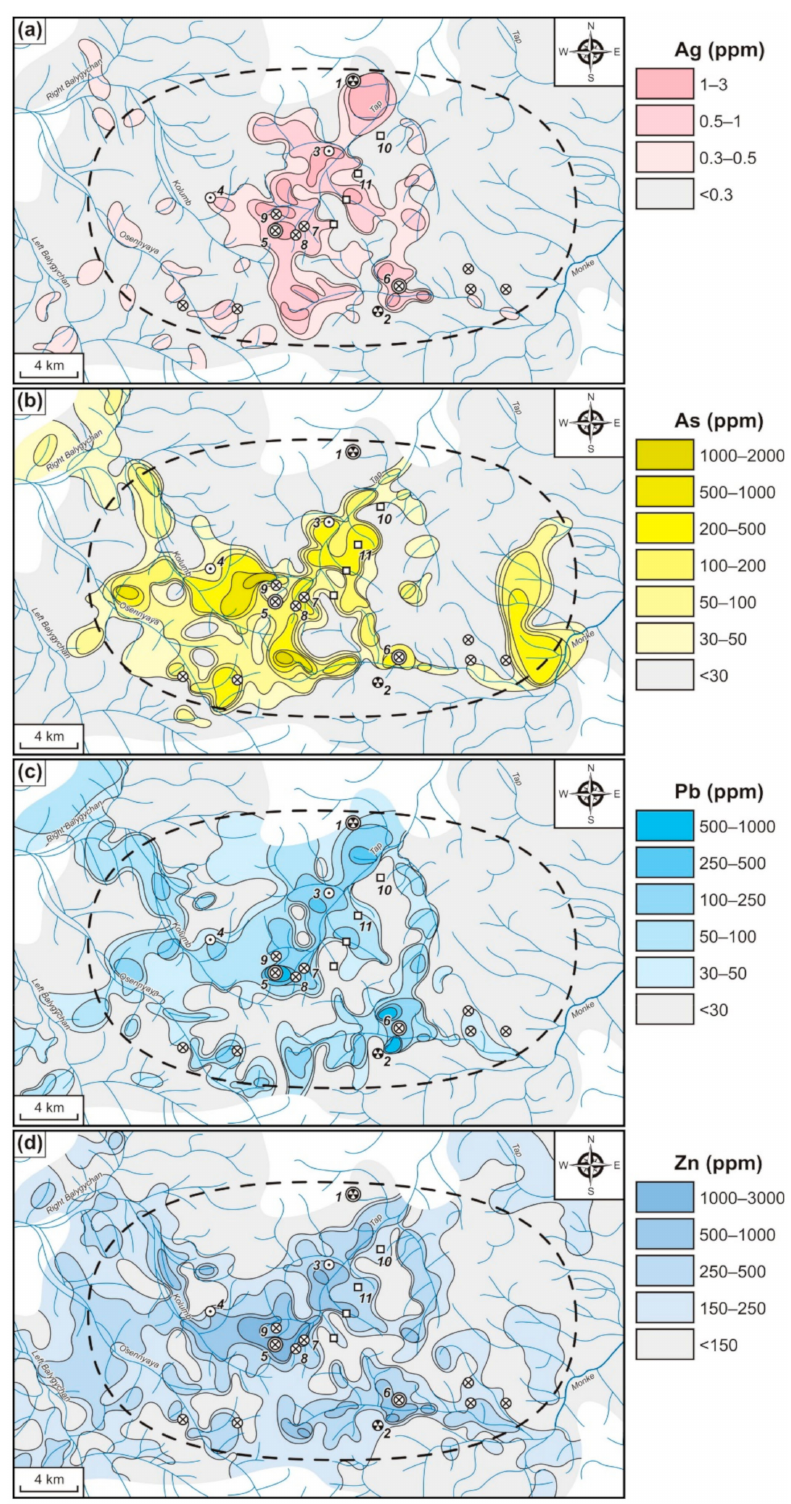
Figure 3. The Pestrinsk SBS. Exogenous Ag ( a ), As ( b ), Pb ( c ), and Zn ( d ) anomalous geochemical fields (AGCFs) identified through SSs (survey at 1:200,000 scale). For the legend to Figures 3–6, see Figure